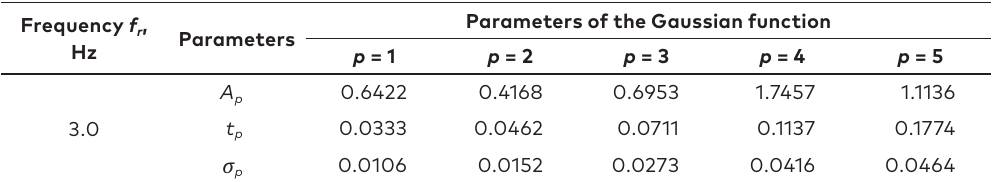
Table 7. Parameters of the template for running frequency of 3.0 Hz